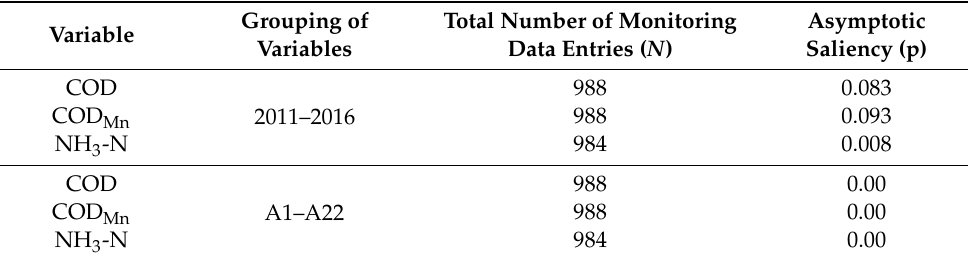
Table 3. Results of the Kruskal–Wallis (K–W) test.